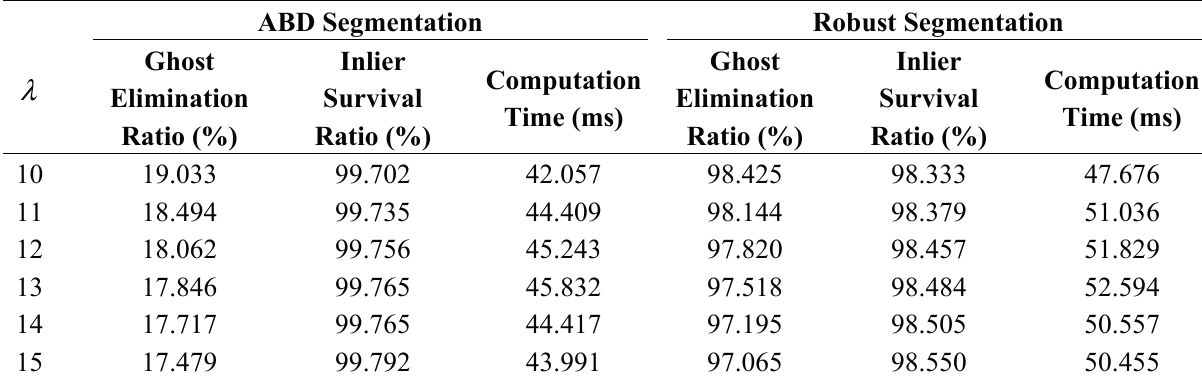
Table 4. Results of ghost elimination for uphill road.